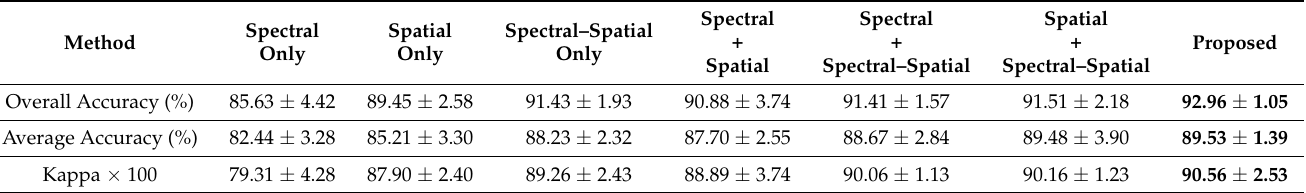
Table 6. Results of ablation studies on different combination of model branches over the GP dataset.